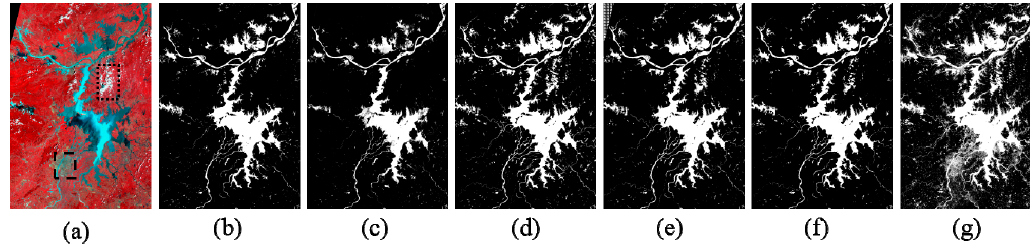
Figure 8. Comparison of water identification effect in Poyang Lake on 29 July 2016. ( a ) False color composite remote sensing image, and water body identification result by ( b ) the DenseNet, ( c ) the ResNet, ( d ) the VGG, ( e ) the SegNet, ( f ) the DeepLab v3+ and ( g ) the NDWI models. White color indicates the identified water bodies, dashed line depicts urban area, dotted line depicts cloud area.